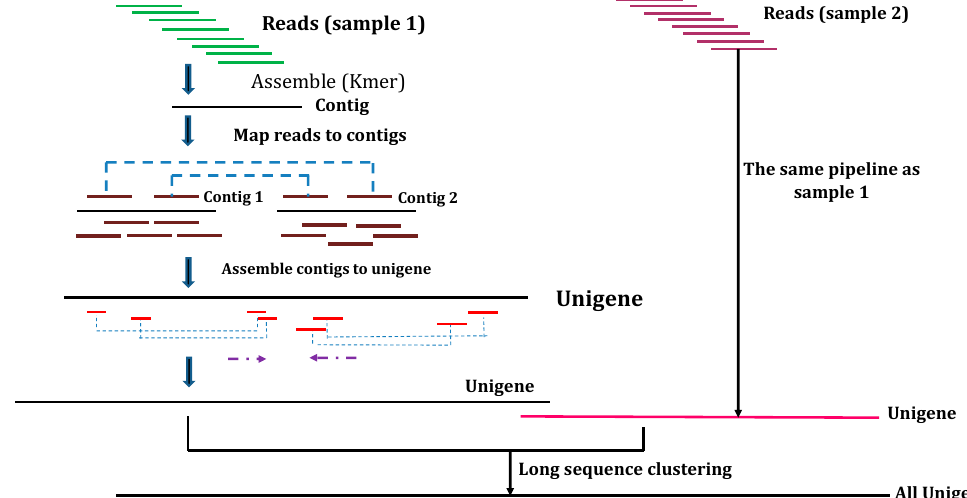
Figure 2. Schematic overview of the de novo transcriptome assembly process.